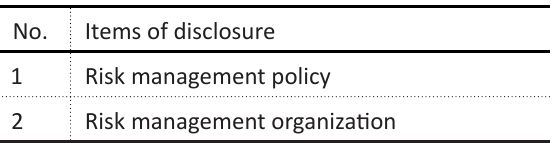
Table 6. Risk management disclosure